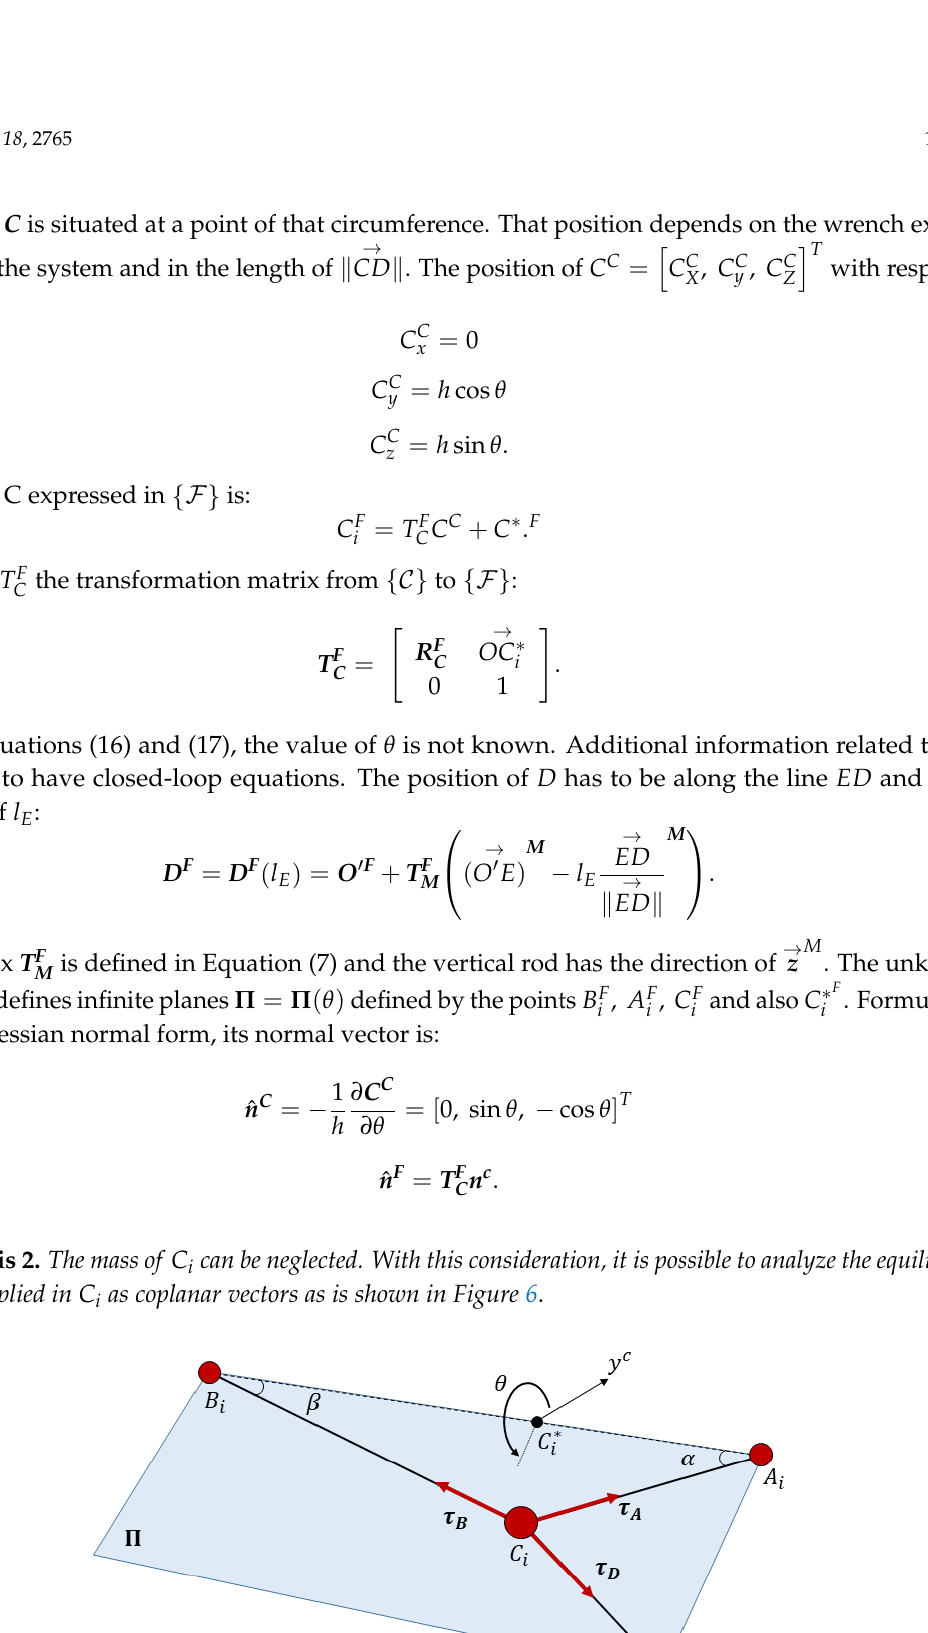
Figure 7. Geometric region of valid existence of point D.